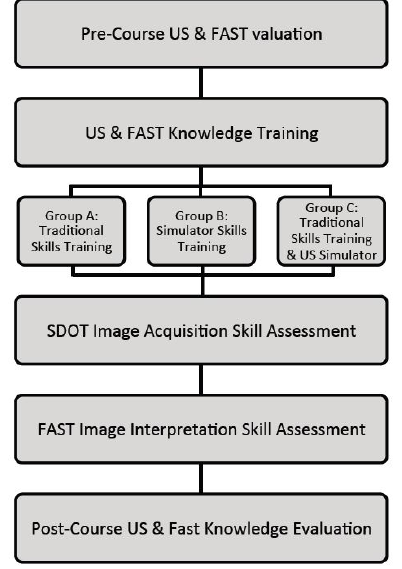
Figure 1. Study design. US, ultrasound; FAST , focused assessment of sonography in trauma; SDOT , standardized direct